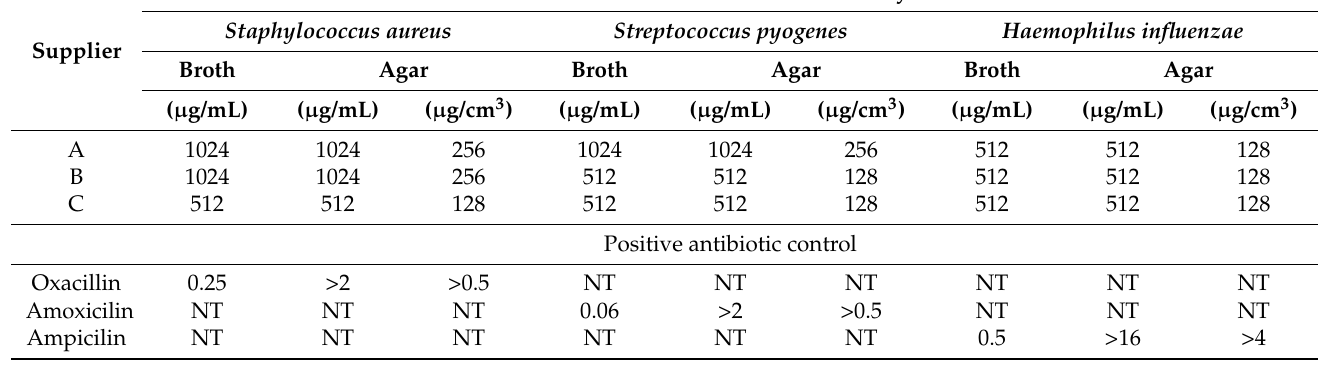
Table 1. In vitro growth-inhibitory effect of Thymus vulgaris L. essential oils in liquid and vapour phases against respiratory infection